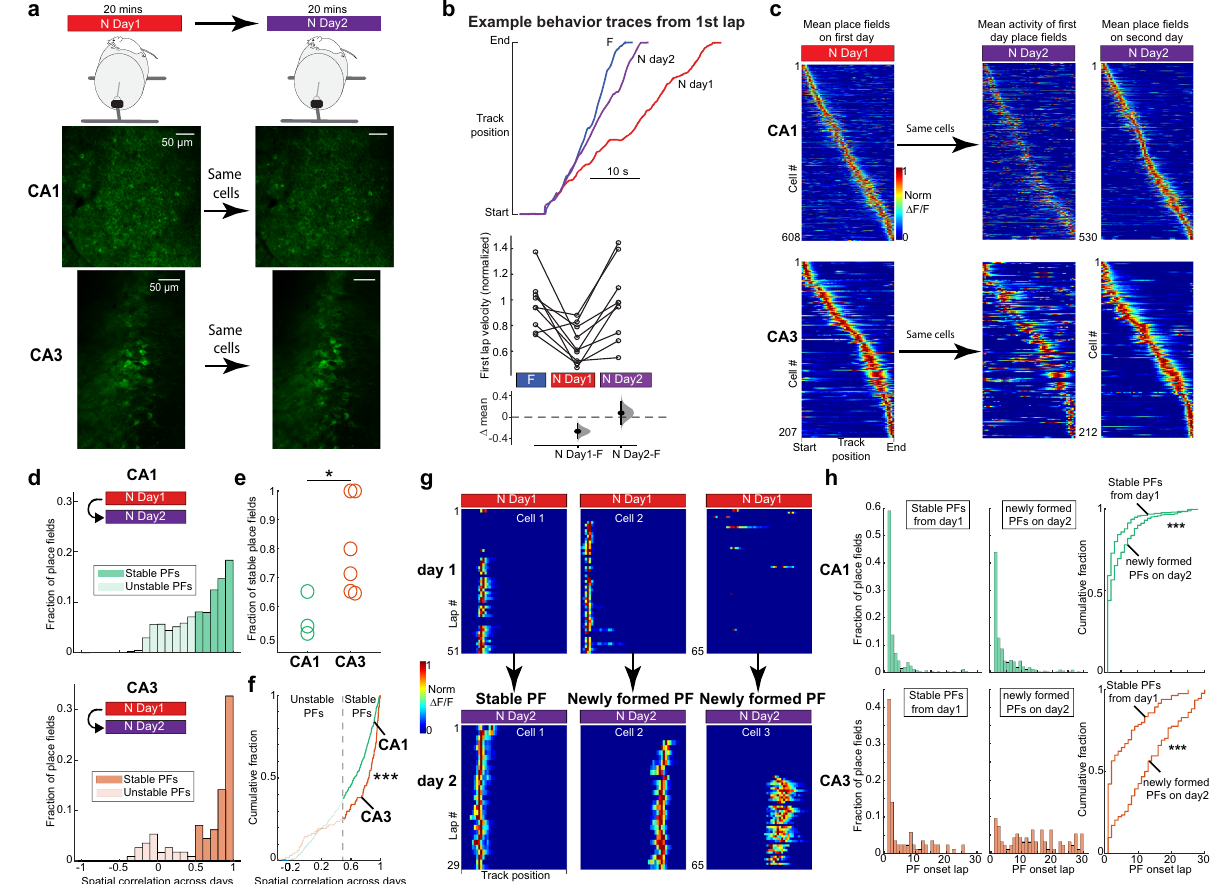
Fig. 4 CA3 place fi elds exhibit higher stability across days than CA1 place fi elds and rapidly reappear upon re-exposure to the environment. a Experimental setup. Top: mice are recorded for 20 min in N across 2 days. Bottom: example fi eld of view from one imaging plane from CA1 and CA3 across 2 days showing the same cells. scale bar = 50 µ m. b Top, example mouse behavior showing track position for the fi rst lap in F (blue), N day 1 (red), and N day 2 (purple). Bottom, summary across all mice of fi rst lap velocity in F, N day 1, and N day 2. Lap velocities were normalized to the mean velocity in F in each mouse ( n = 11 mice). Bootstrapped mean difference ( Δ ) between F and N day 1, and F and N day 2. Note that lap velocity is only different on N day 1. c Left: mean place fi elds in N on day 1 sorted by track position. Middle: mean activity of the same neurons on the left on day 2 in N. Right: mean place fi elds in N on day 2 sorted by track position. d Histograms of Pearson ’ s correlation coef fi cient of average activity map across days in N. Spatial correlations >0.5 were considered stable place fi elds and less than 0.5 unstable. CA1 n = 409, CA3 n = 113 neurons with PFs in both sessions. e Fraction of stable place fi elds across days per mouse in CA1 and CA3. Wilcoxon rank-sum test, two-sided. * P < 0.05, P = 0.0476. f Cumulative fraction plots of Pearson ’ s correlation coef fi cient in N across days in CA1 and CA3 from the same data shown in c . Wilcoxon rank-sum test, two-sided. *** P < 0.001, P = 6.9 × 10 − 4 . g Example of a stable place fi eld (left), an unstable place fi eld with a newly formed place fi eld on day 2 (middle), and a newly formed place fi eld on day 2 (right). Place fi eld transients showed lap-by-lap for all laps in N on day 1 and day 2 from the same three cells. h Histograms of place fi eld onset laps in N on day 2 for stable place fi elds (left), and newly formed place fi elds (middle) in CA1 (top) and CA3 (bottom). Right: cumulative fraction plots of histogram data. Wilcoxon rank-sum test, two-sided. *** P < 0.001, CA1, P = 1.8 × 10 − 5 , CA3, P = 6.7 × 10 − 10 . CA1 stable n = 251 PFs, newly formed, n = 333 PFs, CA3 stable n = 72 PFs, newly formed, n = 94